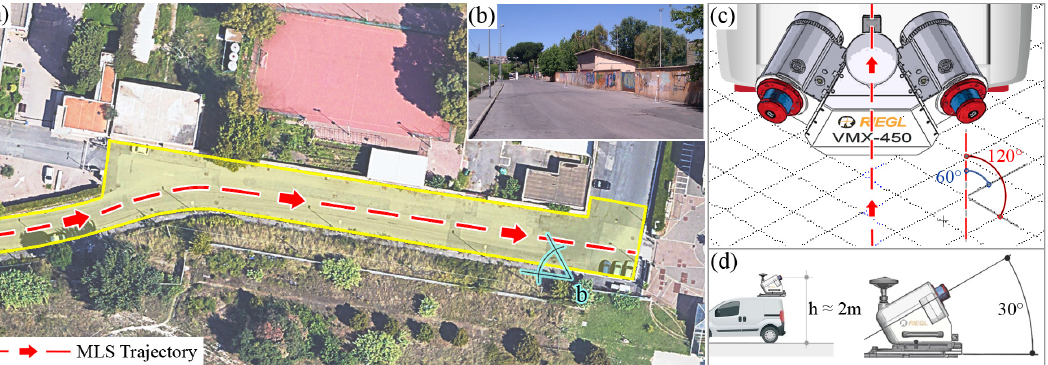
Figure 9. Test case. ( a ) Top view of the road, the area in yellow corresponds to the analyzed road surface; ( b ) a picture of the road; ( c ) an axonometric view of the scanning geometry; ( d ) side views of the MLS system.